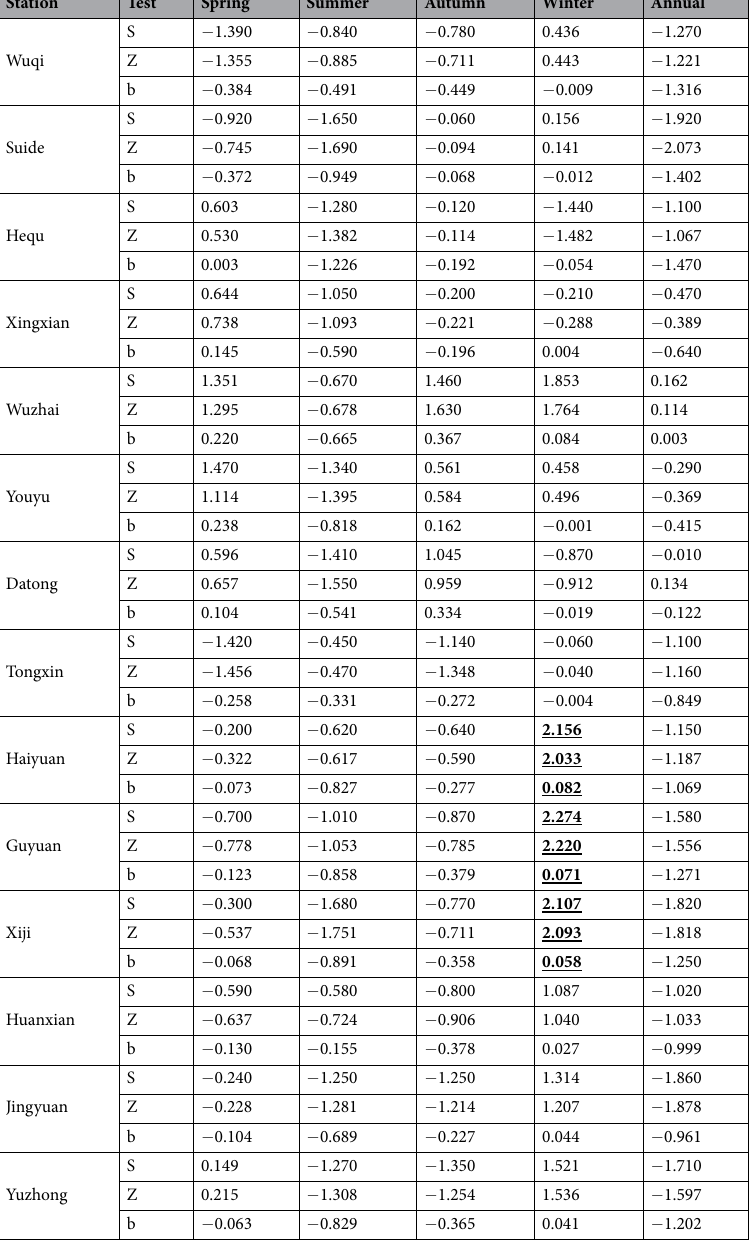
Table 4. Results of the statistical tests of seasonal and annual precipitation in the study period. Z: M-K trend test; S: Spearman’s rho test; and b (mm/a): slope of linear regression. Bold type represents trends identified by 2 statistical methods and trends that are statistically significant at the 5%